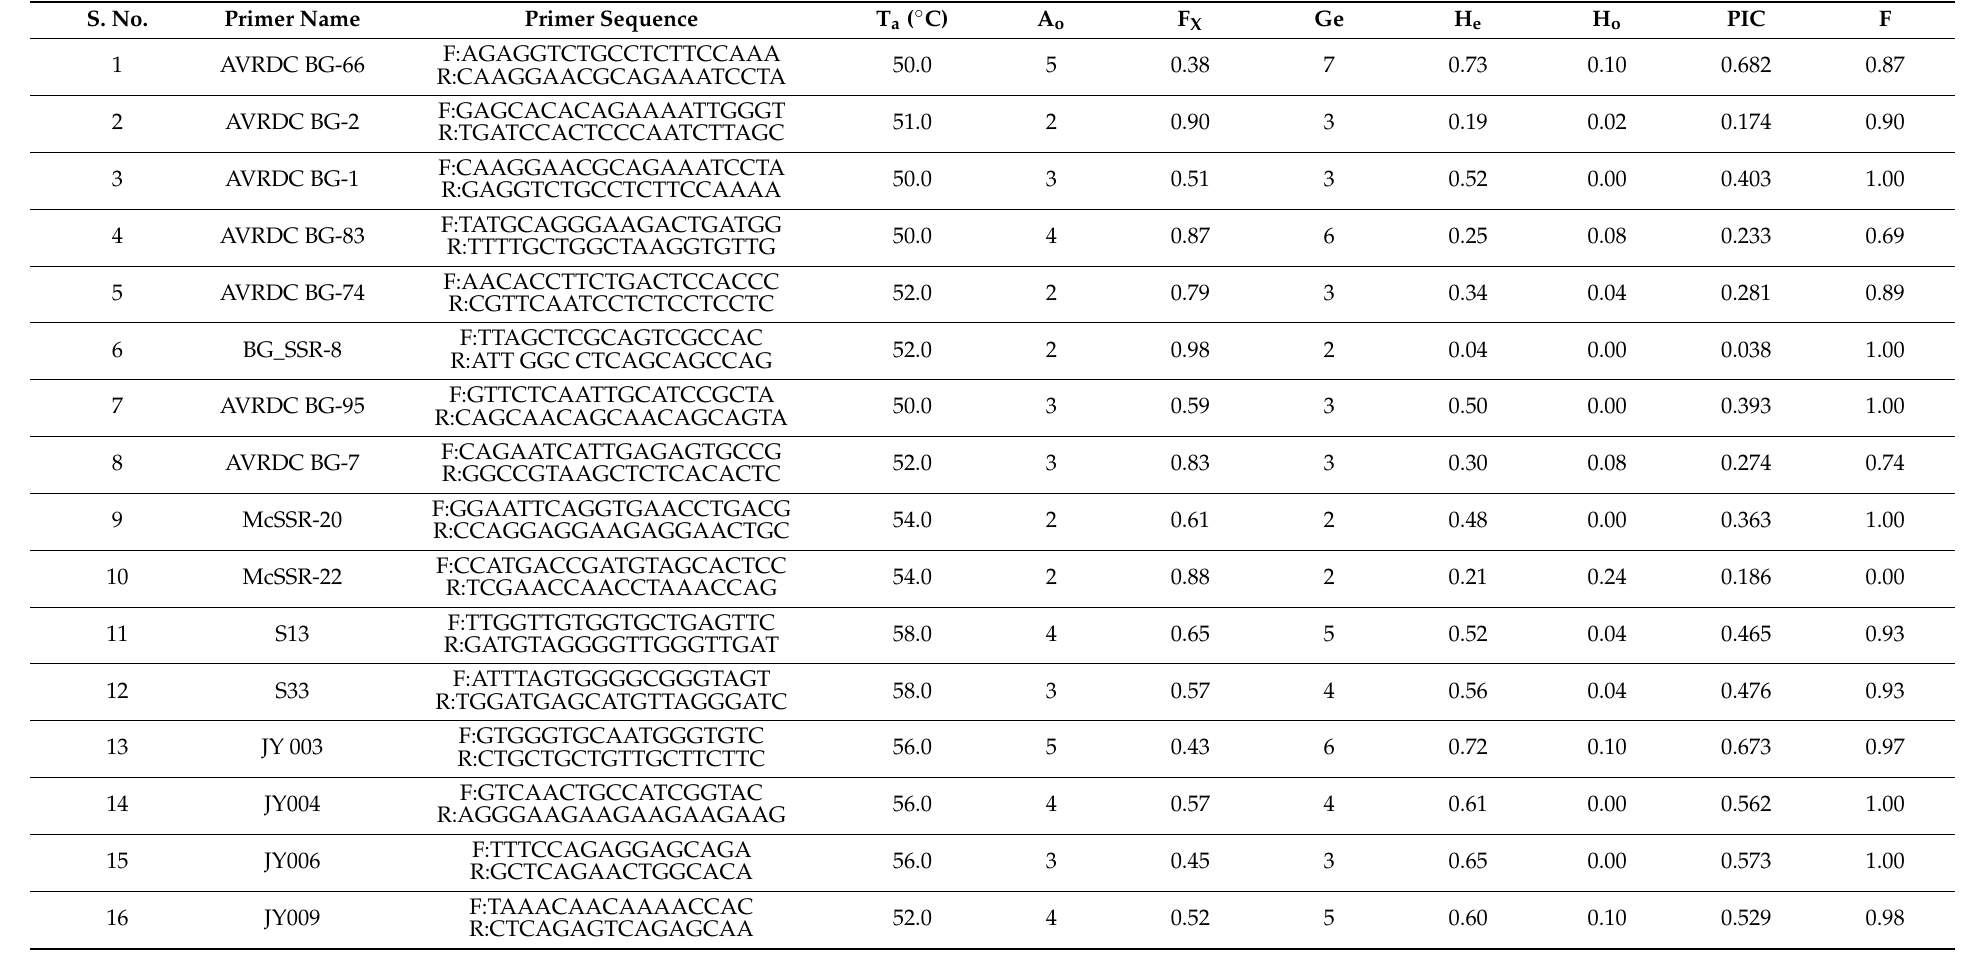
Table 2. Characteristics of the 30 investigated SSR markers and the diversity detected in 51 bitter gourd